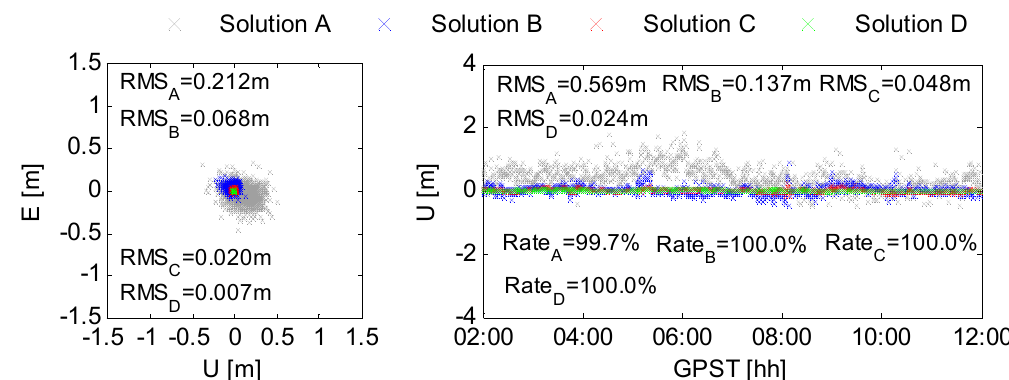
Figure 13. Single-epoch PPP ambiguity-fixed results at P565 with GPS/Galileo triple-frequency data.